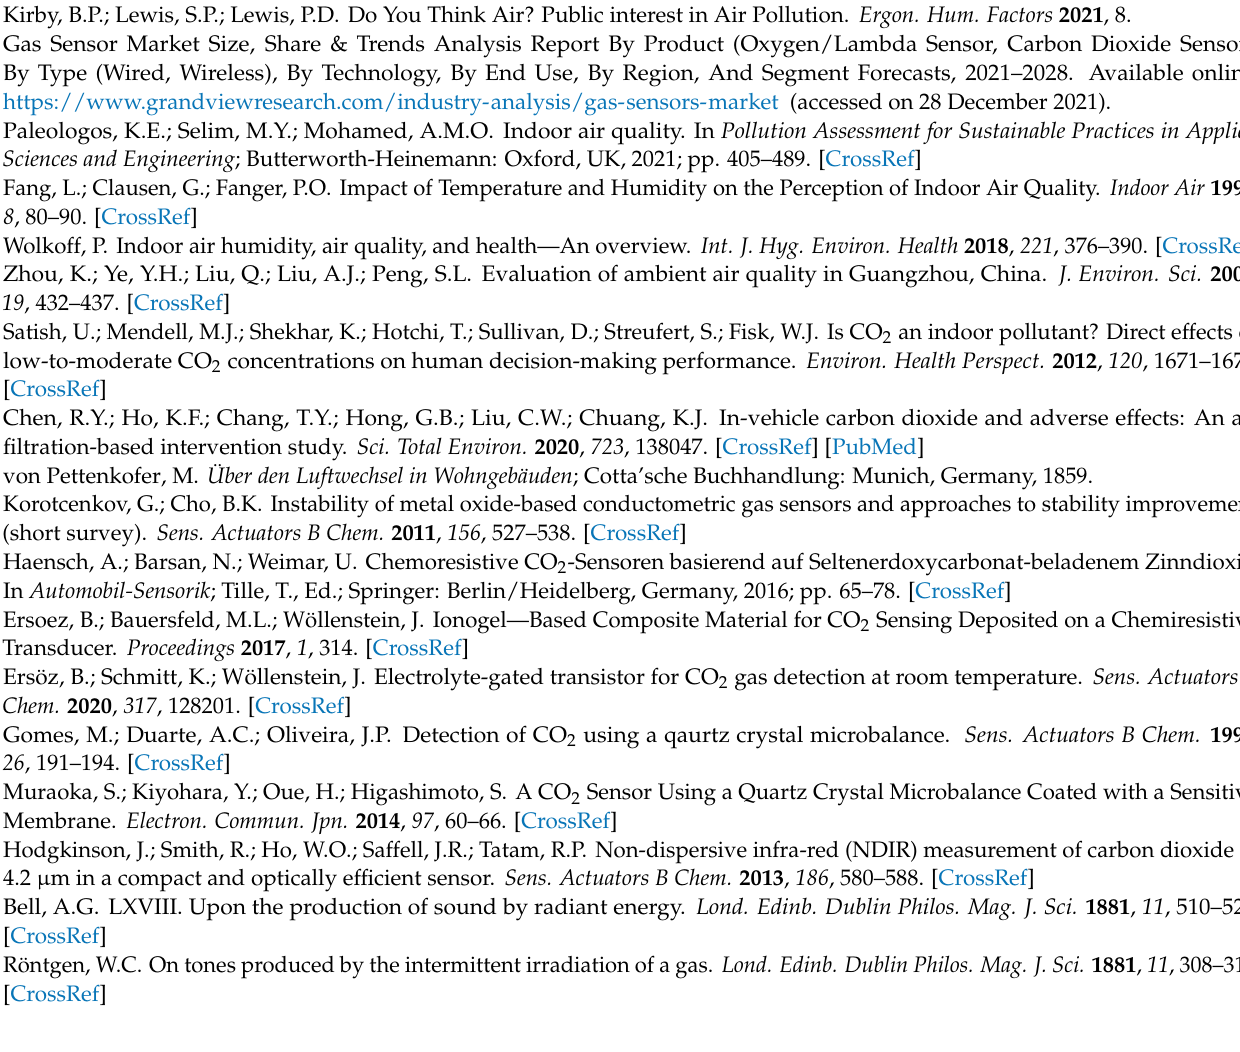
Figure A4. Absolute signal response and quadratic regression curve of d = 15.5 mm sample to applied CO 2 concentrations. Error bars represent standard deviation.